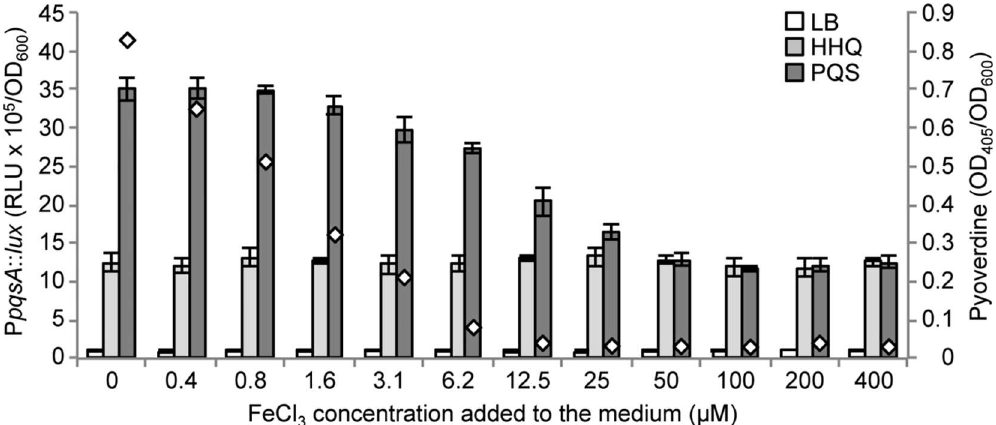
Fig 6. Effect of iron on the ability of PQS to stimulate P pqsA activity. Maximal P pqsA promoter activity measured in the P . aeruginosa Δ 4AQ strain carrying the transcriptional fusion P pqsA :: lux , grown in LB (white bars) or in LB supplemented with 40 μ M HHQ (light-grey bars) or 40 μ M PQS (dark-grey bars), and FeCl 3 at the concentration indicatedbelow the graph. White diamonds indicate the pyoverdine level in the supernatants of cultures grown in the presence of PQS with or without FeCl 3 . Promoter activity and pyoverdineare reported as Relative Light Units (RLU) and OD 405 , respectively, normalizedto cell density (OD 600 ). The averageof three independent experiments is reported with standard